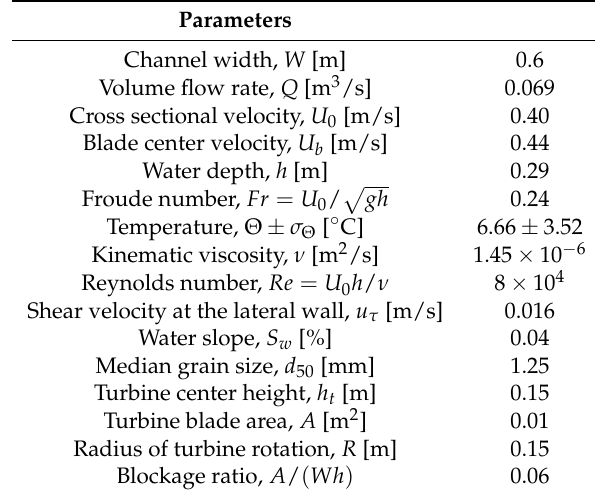
Figure 1. Schematic view of the turbine system. Table 1. Experimental